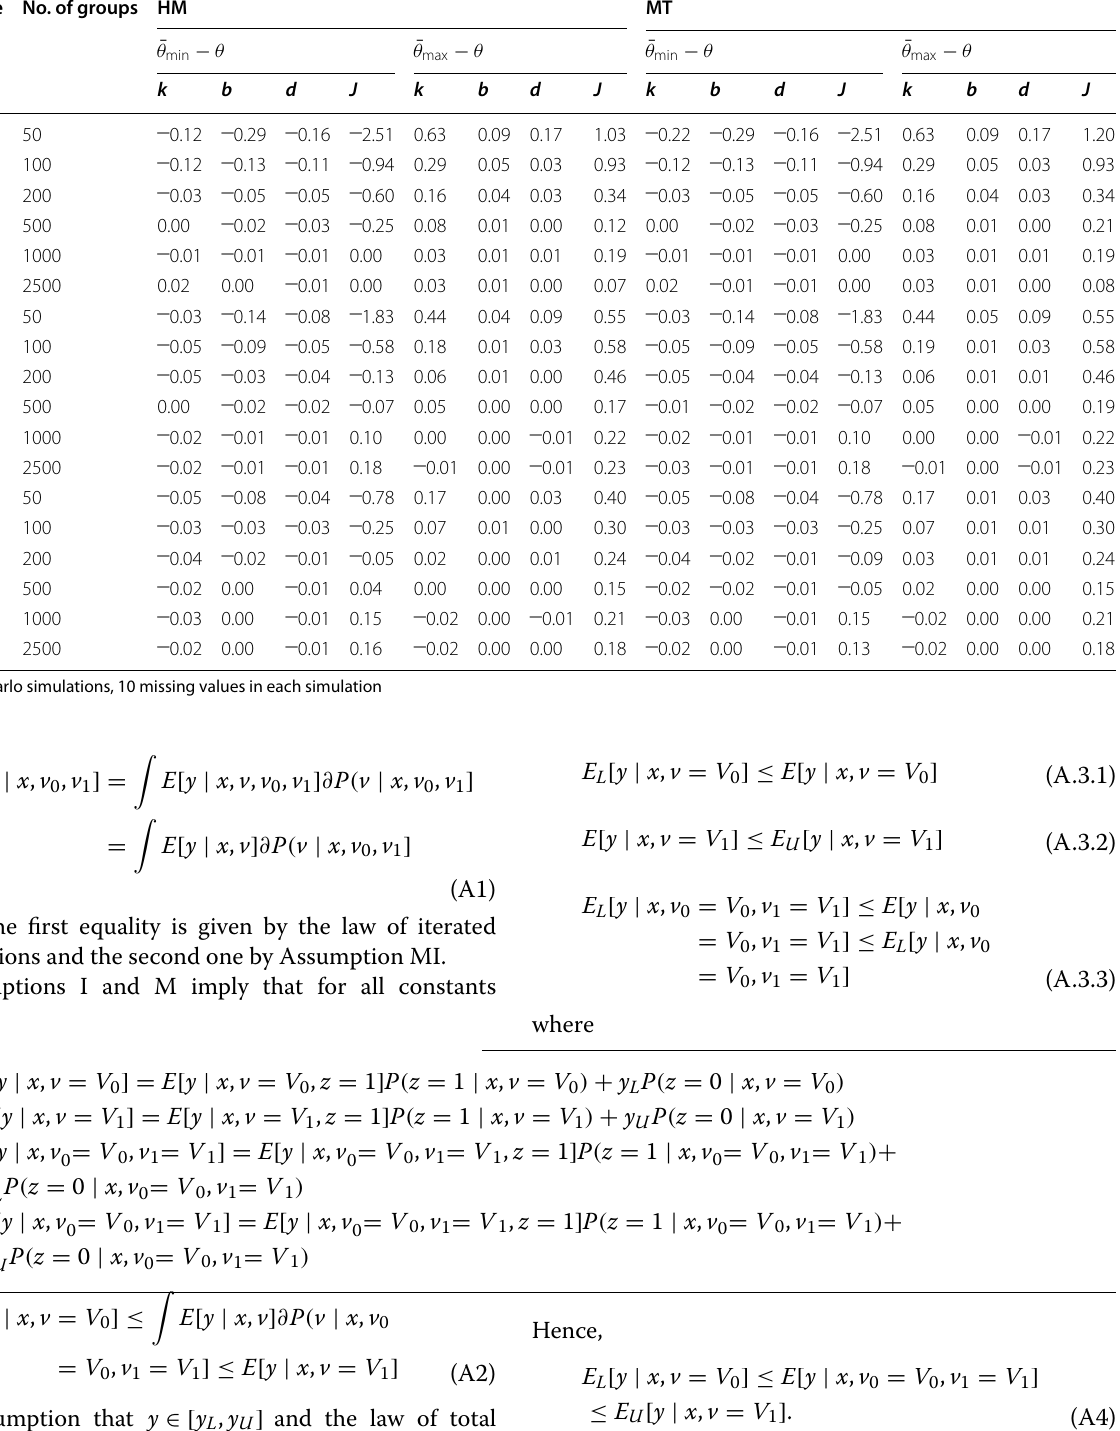
Table 6 Minimum and maximum bounds around the true coefficients of the Horowitz–Manski and Manski–Tamer estimators of the logit endogenous social interactions model with non-closed groups and individuals excluded from their own peer group Group size No. of groups